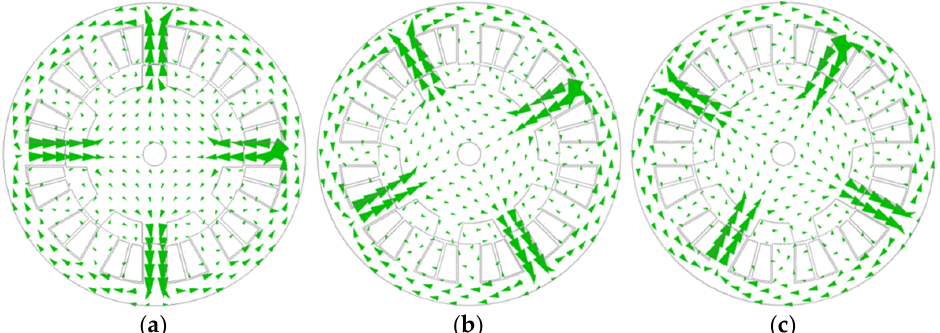
Figure 2. Magnetic field vector of traditional 12/8 SRM. ( a ) Phase A windings excited only; ( b ) Phase B windings excited only; ( c ) Phase C windings excited